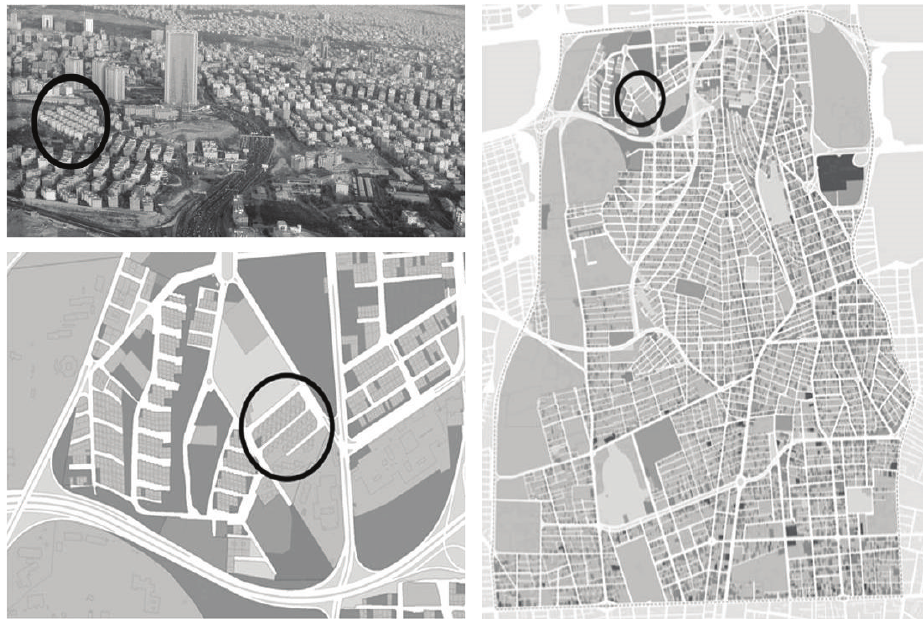
Figure 9: The location of study area in Tehran 6th urban